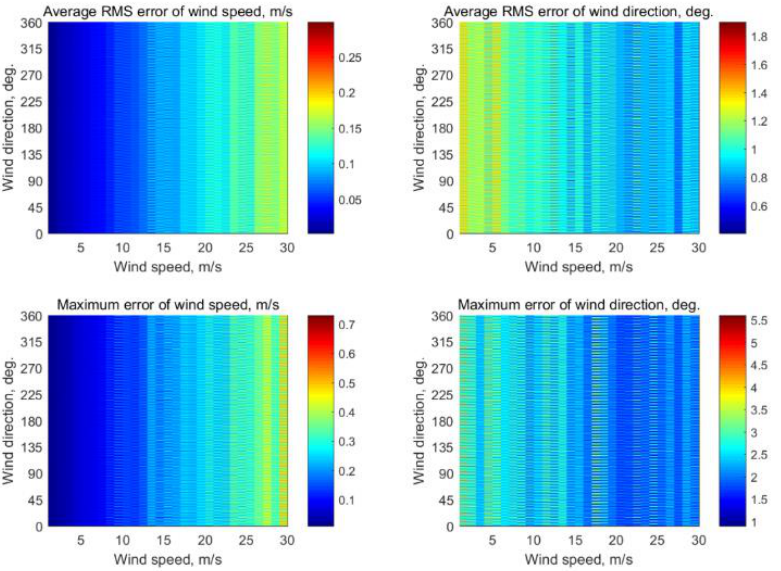
Figure A20. Simulation results of the use of four incidence angles of 35 ◦ , 40 ◦ , 45 ◦ , and 50 ◦ for wind